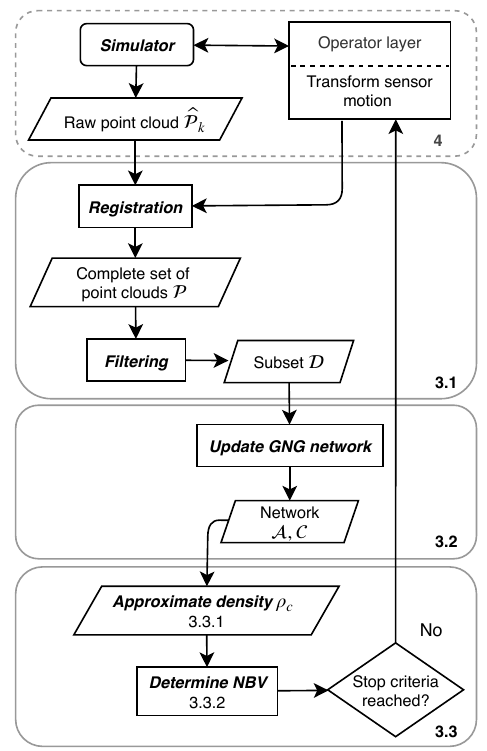
Figure 1. Flowchart of the complete NBV pipeline with the re- lated sections. The chart is divided in four parts, beginning at the top with the dashed grey line which indicates the data generation, described in Section 4. The following solid grey parts belong to the methodology explained in Section